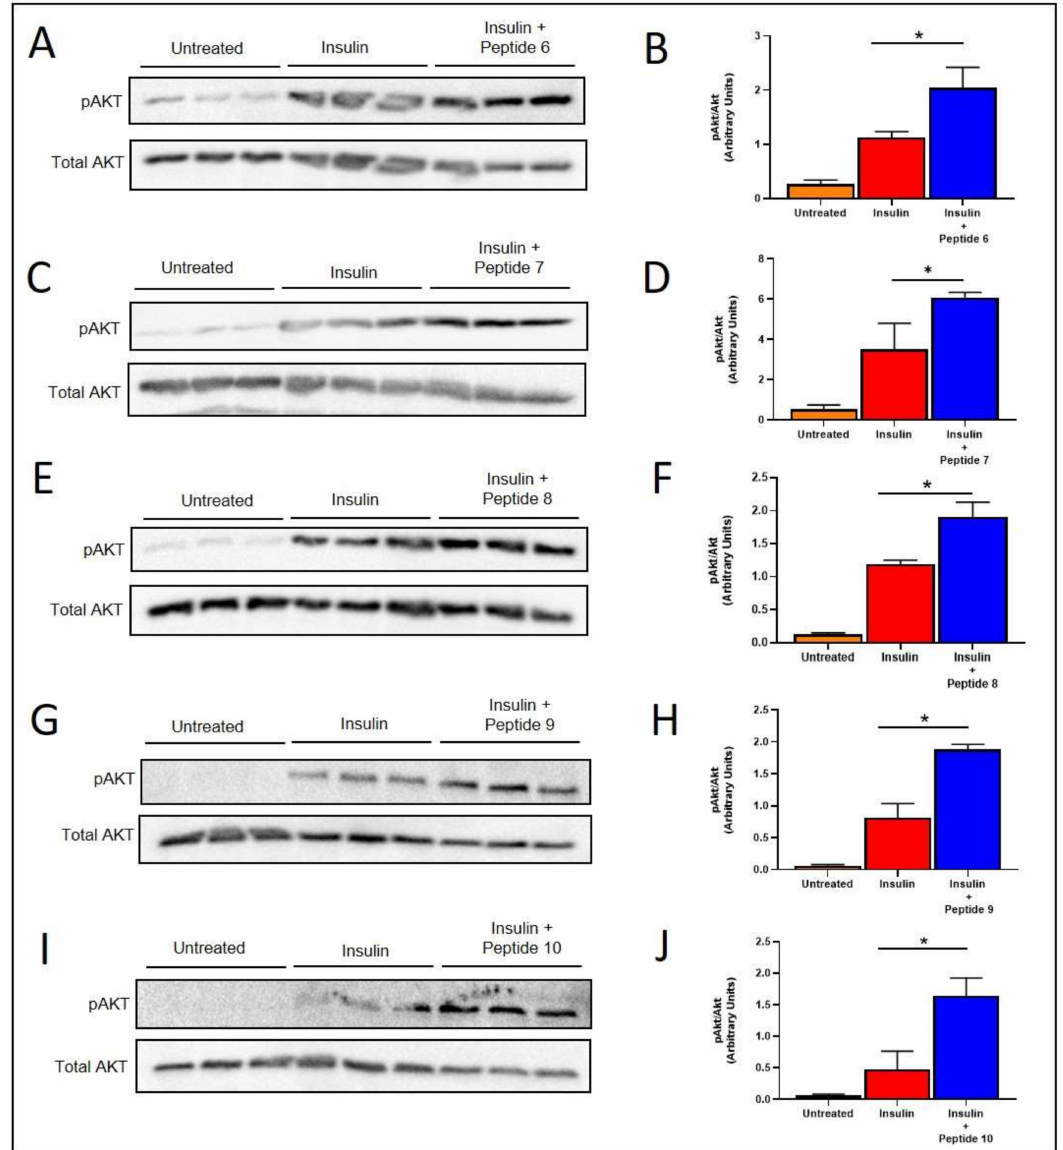
Figure 3. TNFSF14 peptides increase insulin signalling in skeletal muscle cells. Cells were treated with either the peptides 6 ( A , B ), 7 ( C , D ), 9 ( G , H ) or 10 ( I , J ) for 48 h prior to acute insulin stimulation. Cells were treated with Peptide 8 ( E , F ) for 24 h prior to acute insulin stimulation. Immunoblots for phospho-AKT and Total AKT ( A , C , E , G , I ) and quantification of pAKT/Total AKT ( B , D , F , H , J ) is shown for each peptide ( n = 3/treatment). Mean ± SD. * p < 0.05. p = 0.02, 0.03, 0.01, 0.01 and 0.001 for ( B , D , F , H , J )